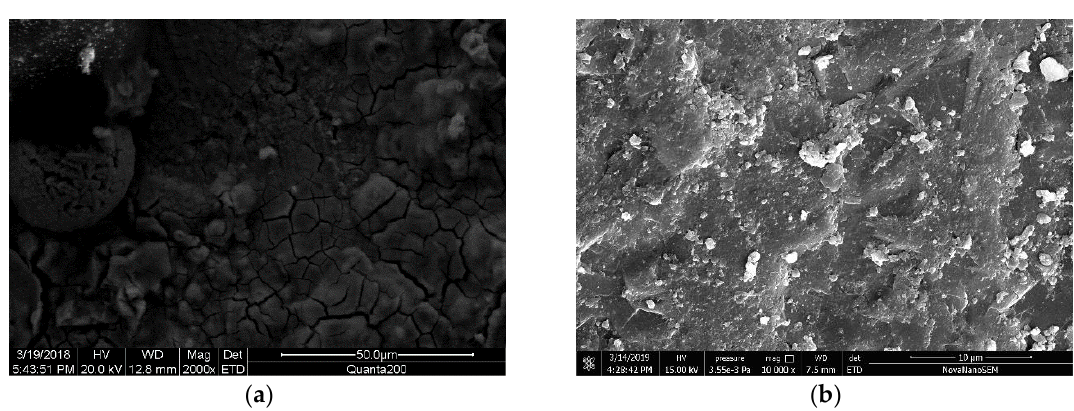
Figure 10. SEM images of rust layer in ordinary concrete under continuous immersion; ( a ) Initial rust layer morphology of B1, ( b ) Later rust layer morphology of B1.